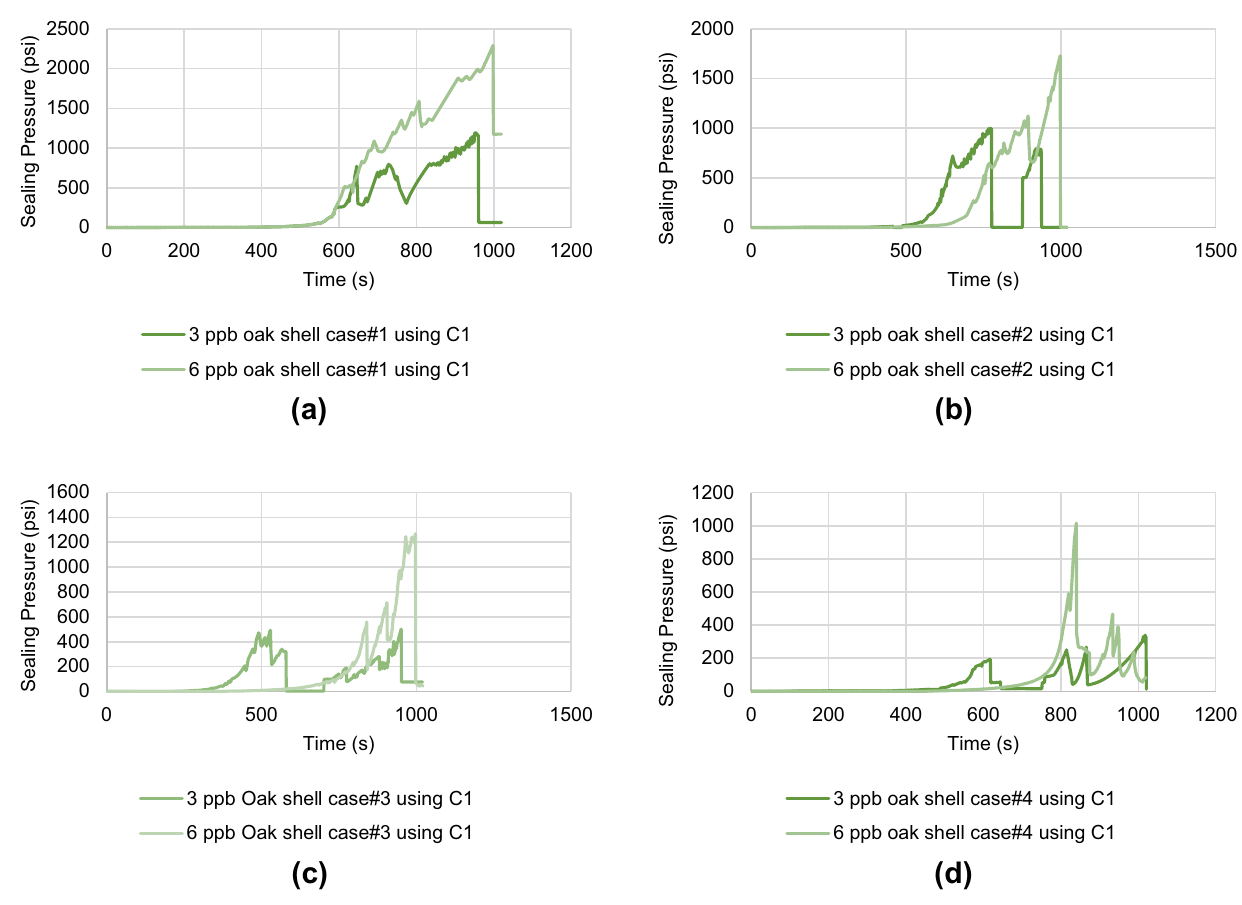
Fig. 25 HPA Pressure versus Time plot for Oak Shell showing maximum sealing pressure at different concentrations, a case#1, b case#2, c case#3, d